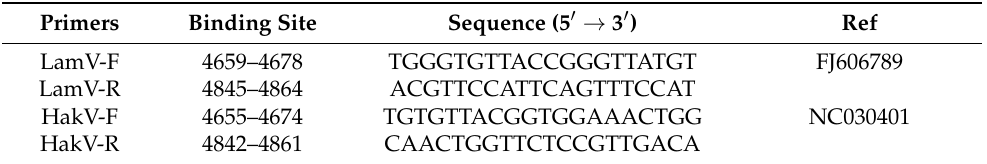
Table 1. Primer pairs used for the qPCR